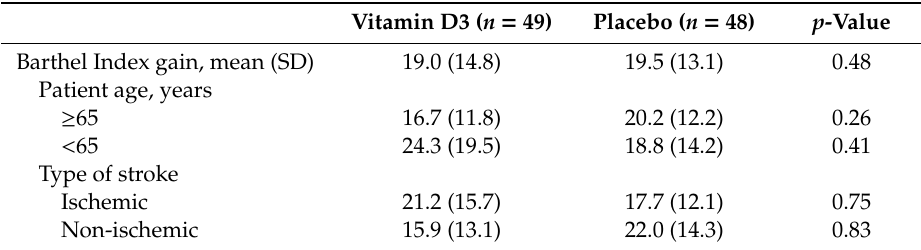
Table 2. Comparison of the primary outcome (gain in Barthel Index score) between the study groups stratified by age and type of